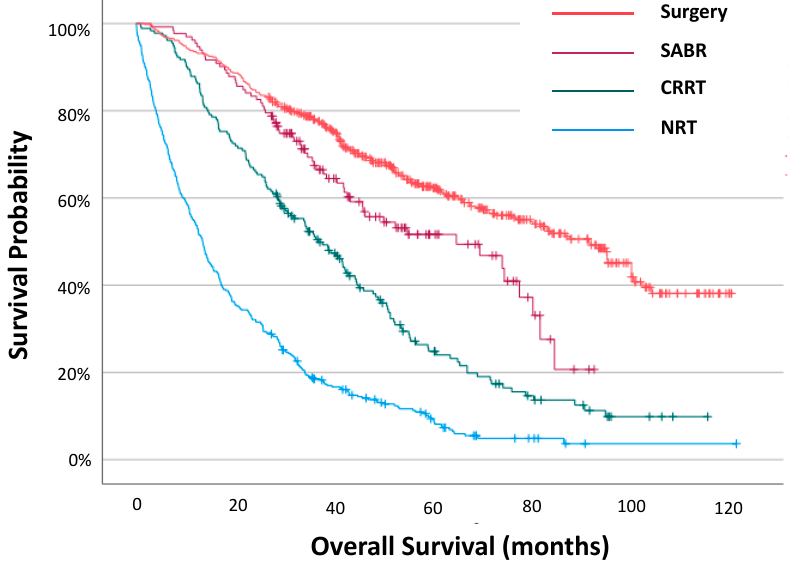
Figure 1. Overall survival for all patients with stage I NSCLC by treatment modality. Outcomes by Time Period: Survival estimates by time period for all patients, and for each treatment subgroup, are shown in Figure 2 (Supplemental Table S3). Patients in time period C had more favourable survival than those in time period A (HR